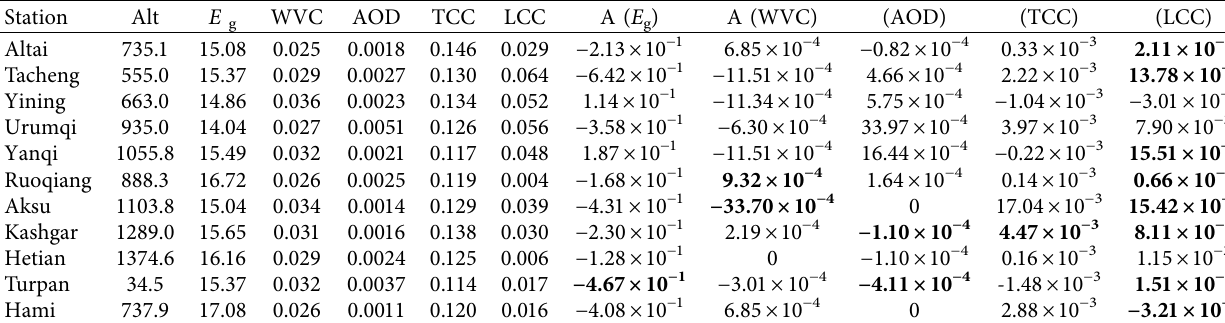
g , WVC, AOD, TCC, and LCC and their long-term trends (A) recorded at each station from 1961 to